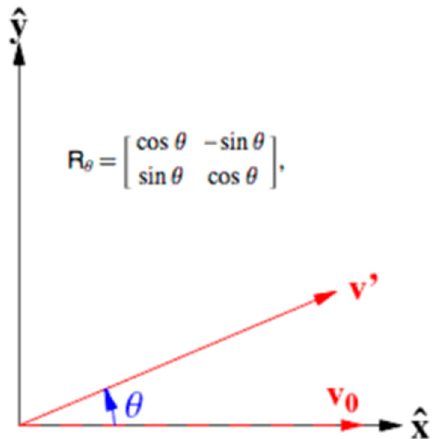
Figure 10. Rotation of data using a rotation matrix.